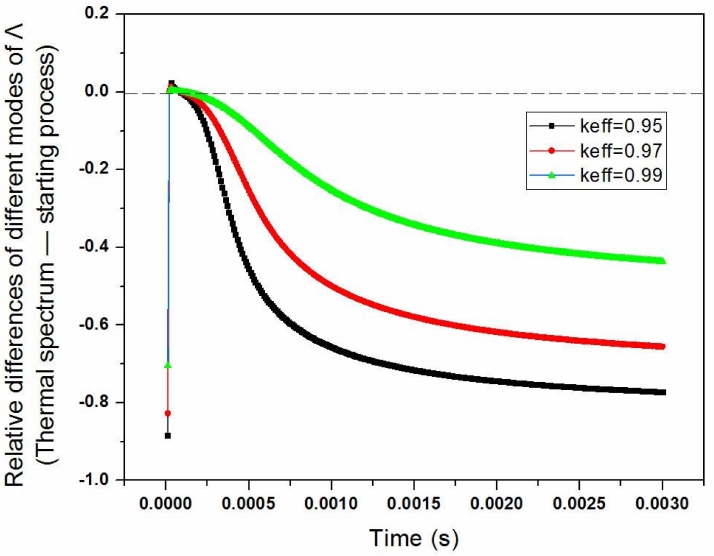
Figure 10. Relative differences in Λ with time for different modes of the thermal spectrum, under different subcriticalities and starting